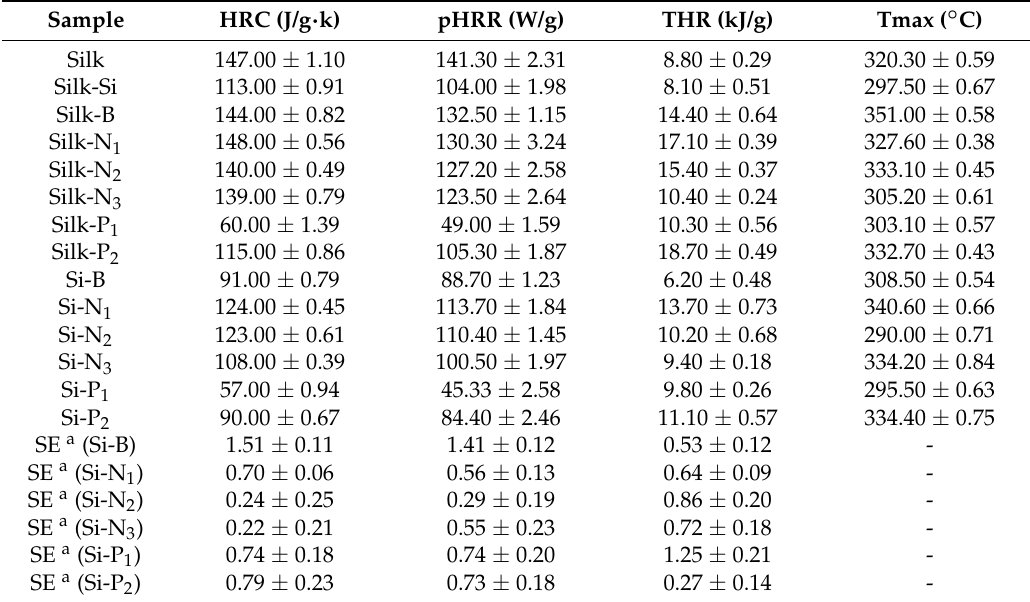
Table 3. Characteristic parameter of the micro calorimeter test for all samples.